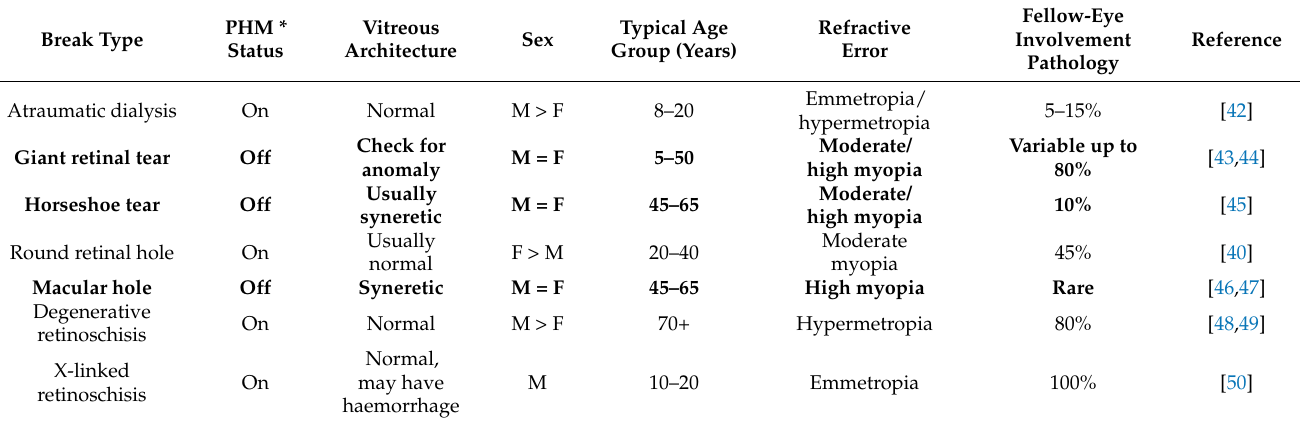
Table 1. The ‘Cambridge Guide’ to the features associated with the seven most common types of primary retinal break in rhegmatogenous retinal detachment. Reproduced and adapted with permission from Ref. [40]. This review focusses on those sub-groups secondary to PVD (highlighted in